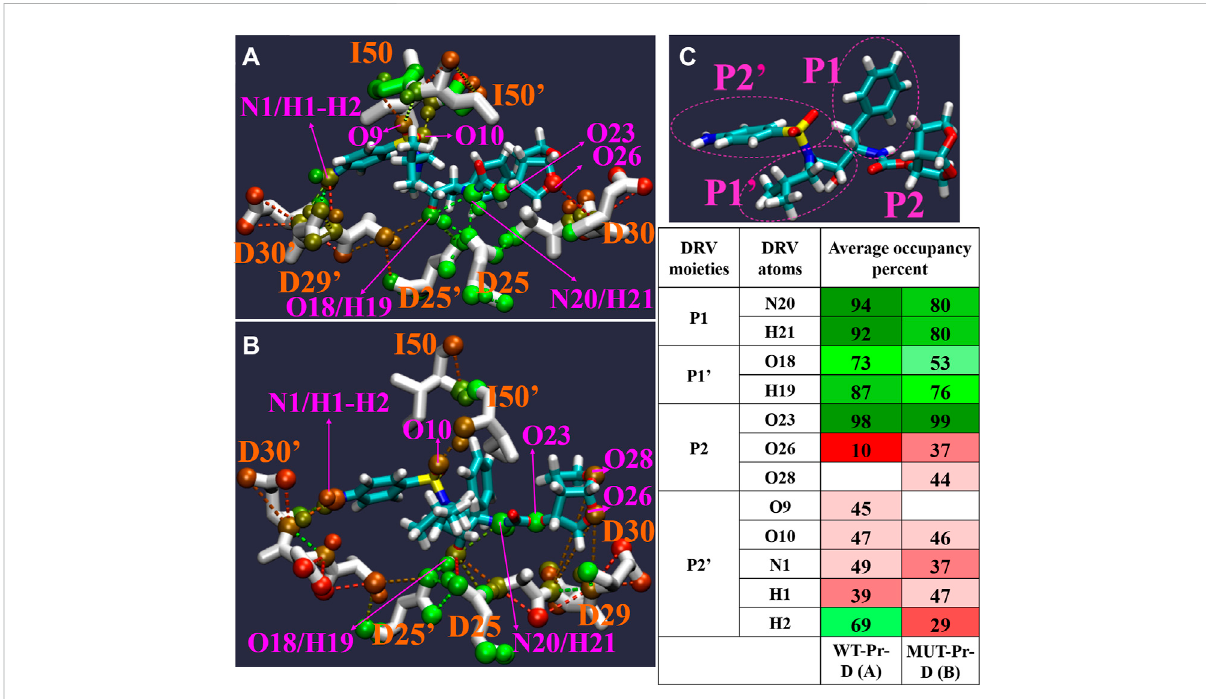
FIGURE 7 The Pattern ofhydrogenbondsnetworks (HB) between DRV with WT-Pr (A) and MUT-Pr (B) inminimum energybasins B and Cwereindicated. (C) the main chemical moieties of DRV, labeled as P1, P1 ’ , P2, and P2 ’ . HBs percent in both basins are illustrated in table; red colors are for hydrogen bondsthattheiroccupancyislowerthan50percent,andgreencolorsareforhydrogenbondsthattheiroccupancyarehigherthan50percent.Only, those HBs that were formed at least in 10 percent of structures and angle between three atoms involving in HBs were between 0 – 60 degree were